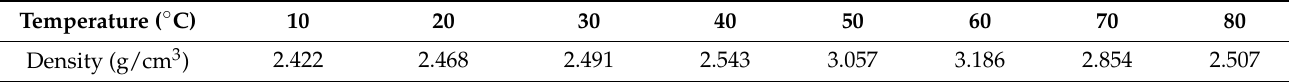
Table 2. Solid density of tailings floc